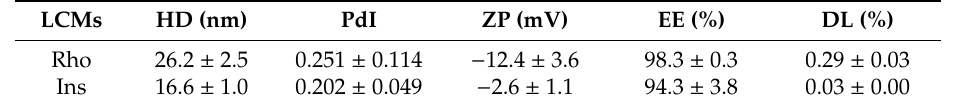
Table 1. Physical-chemical properties of rhodamine 123 (Rho) and insulin (Ins)-loaded lipid-core micelles (LCMs). Values are presented as mean ± standard deviation ( n = 3).